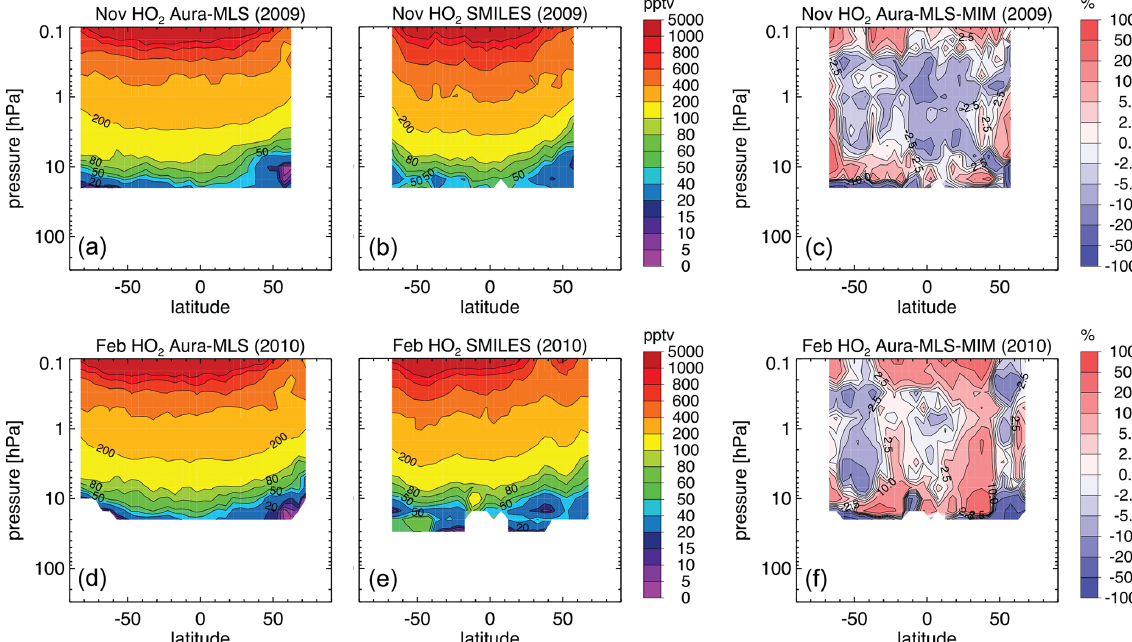
Figure 14. Zonal monthly mean HO 2 cross sections for Aura-MLS and SMILES daytime (LT) data (left two columns) and Aura-MLS relative differences from the MIM (c, f) are shown for November 2009 (a, b, c) and February 2010 (d, e, f) , respectively. Note that the SMILES relative differences from the MIM would look like exact opposites of these figures and thus are not shown. Table 16. Time period, vertical range, vertical resolution, references, and other comments for HO 2 measurements.